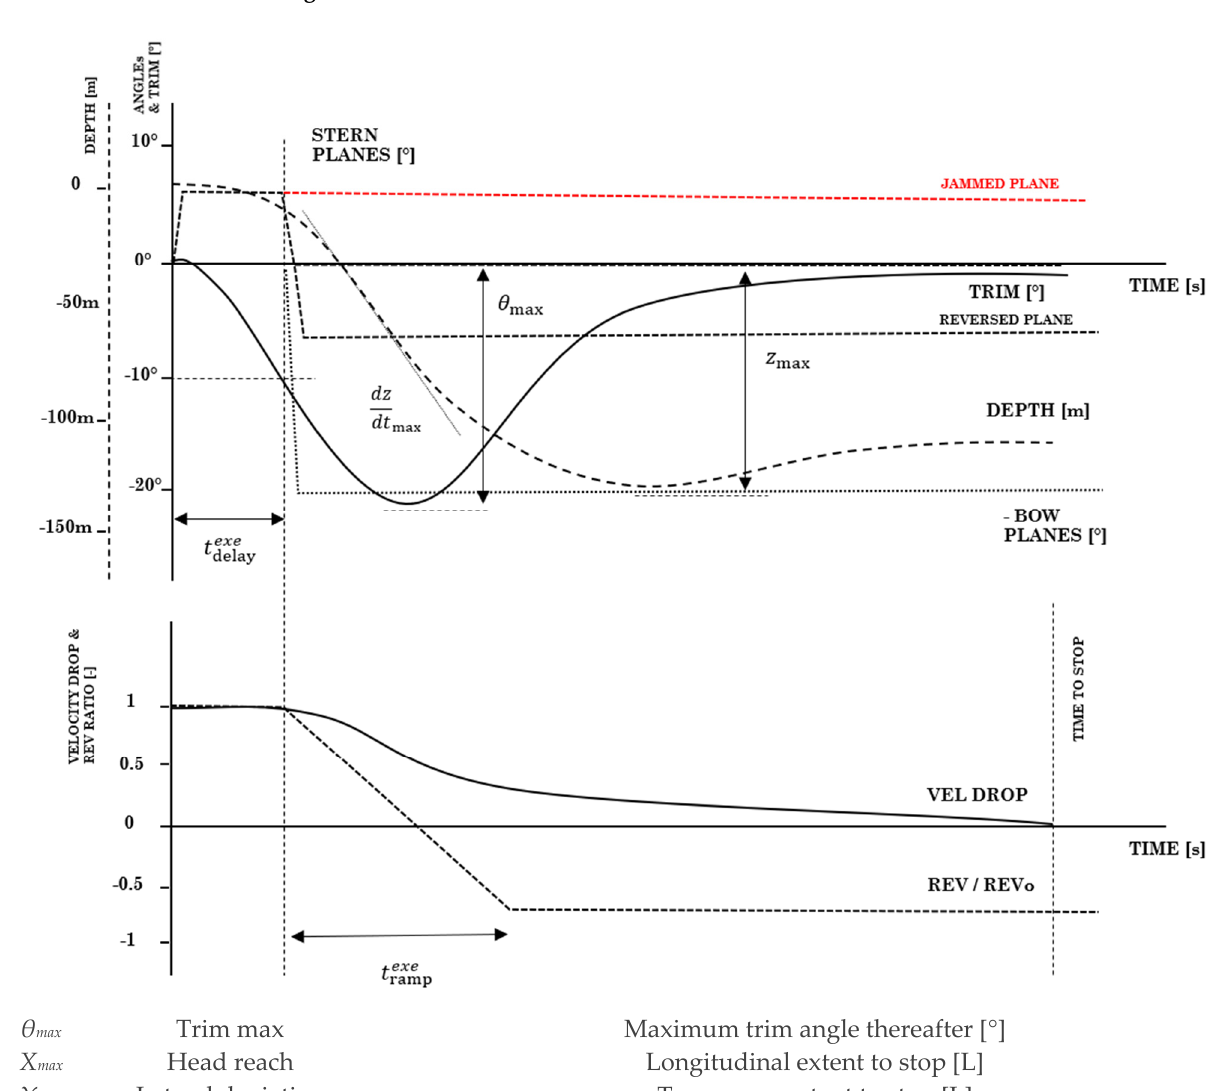
Figure A4. Dive fail time-series and characteristics.